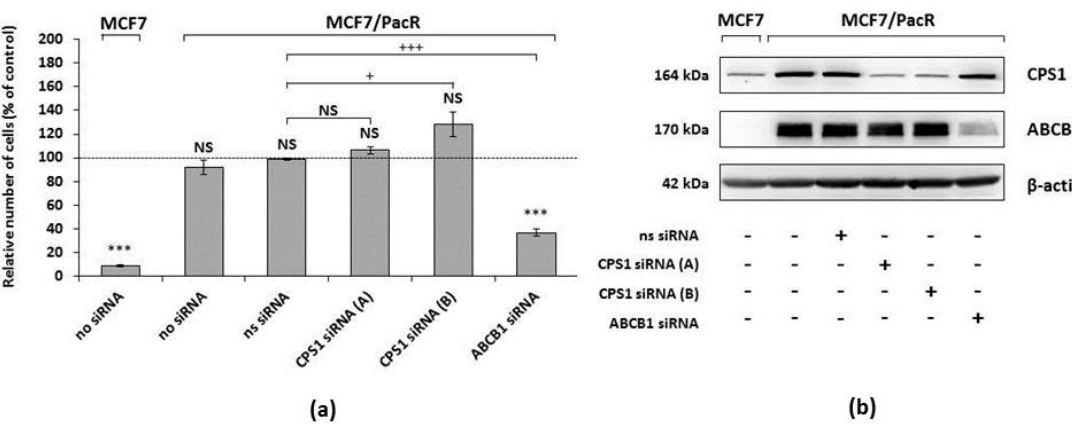
Figure 7. The effect of CPS1 (carbamoyl-phosphate synthetase 1) silencing and ABCB1